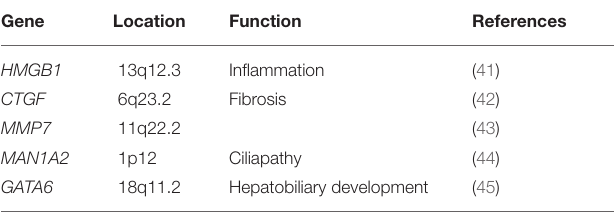
TABLE 2 | Differential expressed gene in